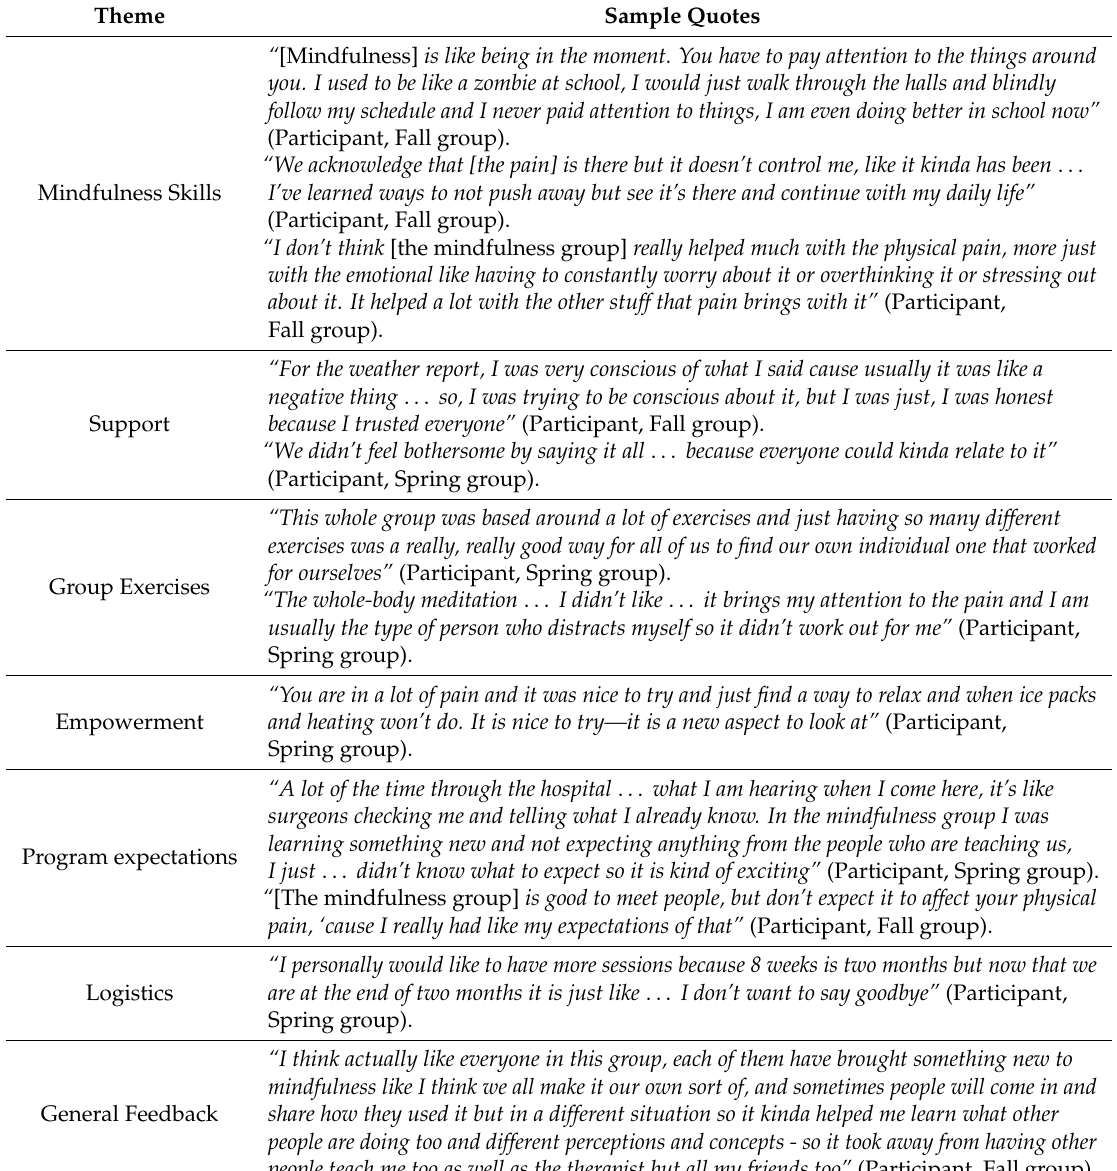
Table A2. Select quotes illustrating main